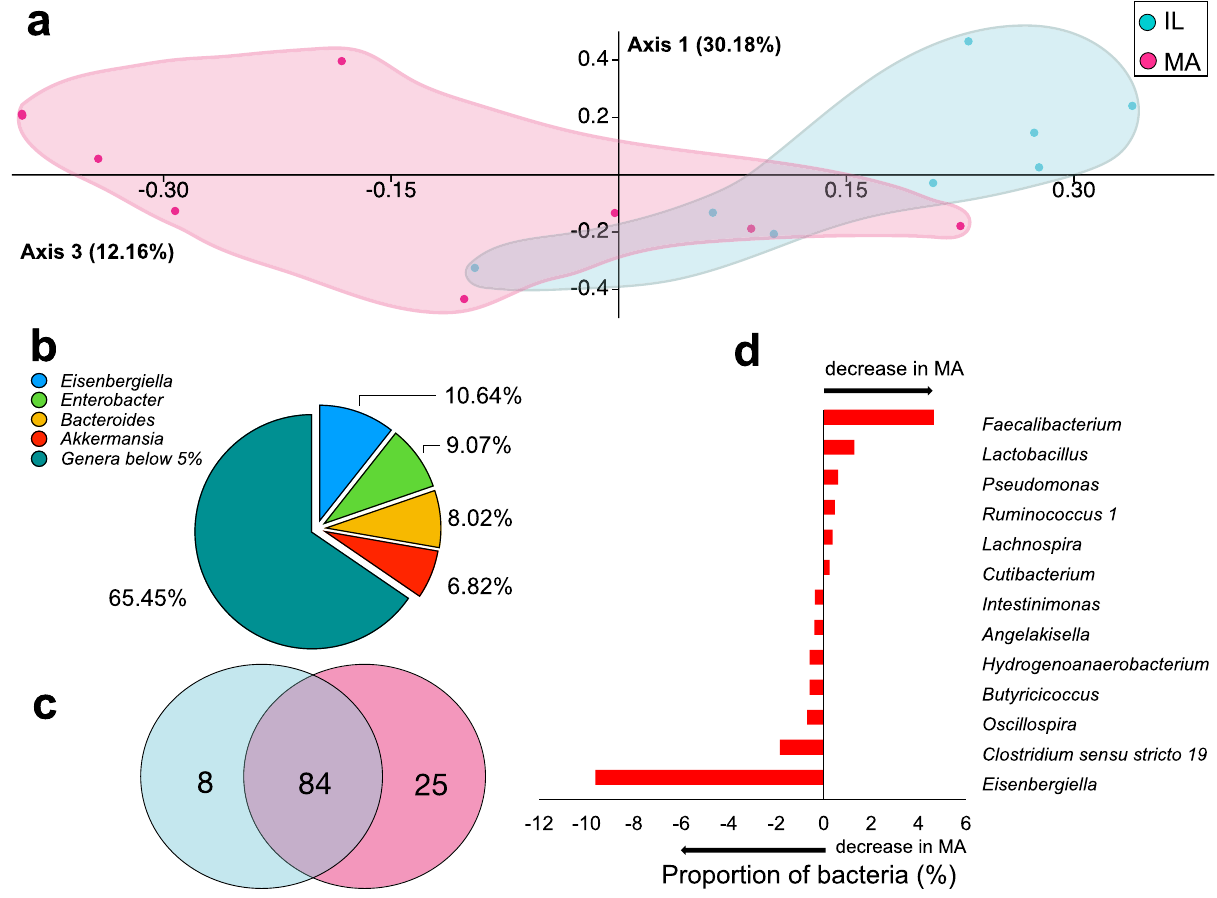
Figure 2. Comparison between island and mainland lizards using the gut microbiota community. ( a ) Principle Coordinate Analysis (PCoA) using Bray–Curtis dissimilarity to test β-diversity between the gut microbiota of IL (island) and MA (mainland) lizards. ( b ) Contribution of bacterial genera to differences among the gut microbiota of IL (island) and MA (mainland) lizards calculated using SIMPER (Similarity Percentages Species Contributions); see Supplementary Table S4 online for details. ( c ) Symmetric Venn diagram of shared and exclusive bacterial genera in the gut microbiota of IL (island) and MA (mainland) lizard groups, produced by Venn Diagram Tool freely available on the web (https:// bioin forma tics. psb. ugent. be/ webto ols/ Venn/); see Supplementary Table S5 online for details. ( d ) Variation of shared bacterial genera showed as the amount of bacteria (%) in the gut microbiota of mainland (MA) compared to island (IL) lizards.